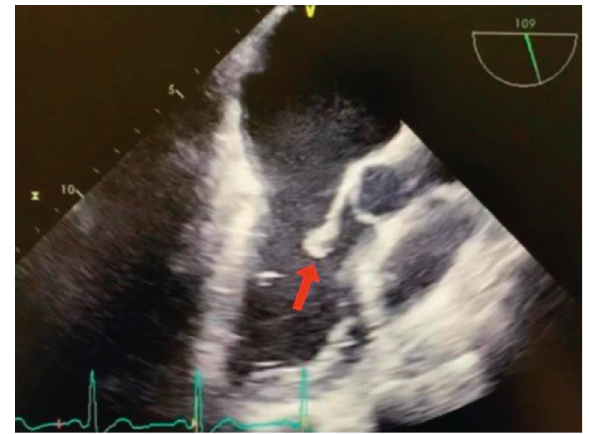
Figure 5: TEE findings noted mitral valve vegetations on the lateral posterior P2 segment (red arrow) and severe mitral regurgitation with systolic reversal of the right pulmonary